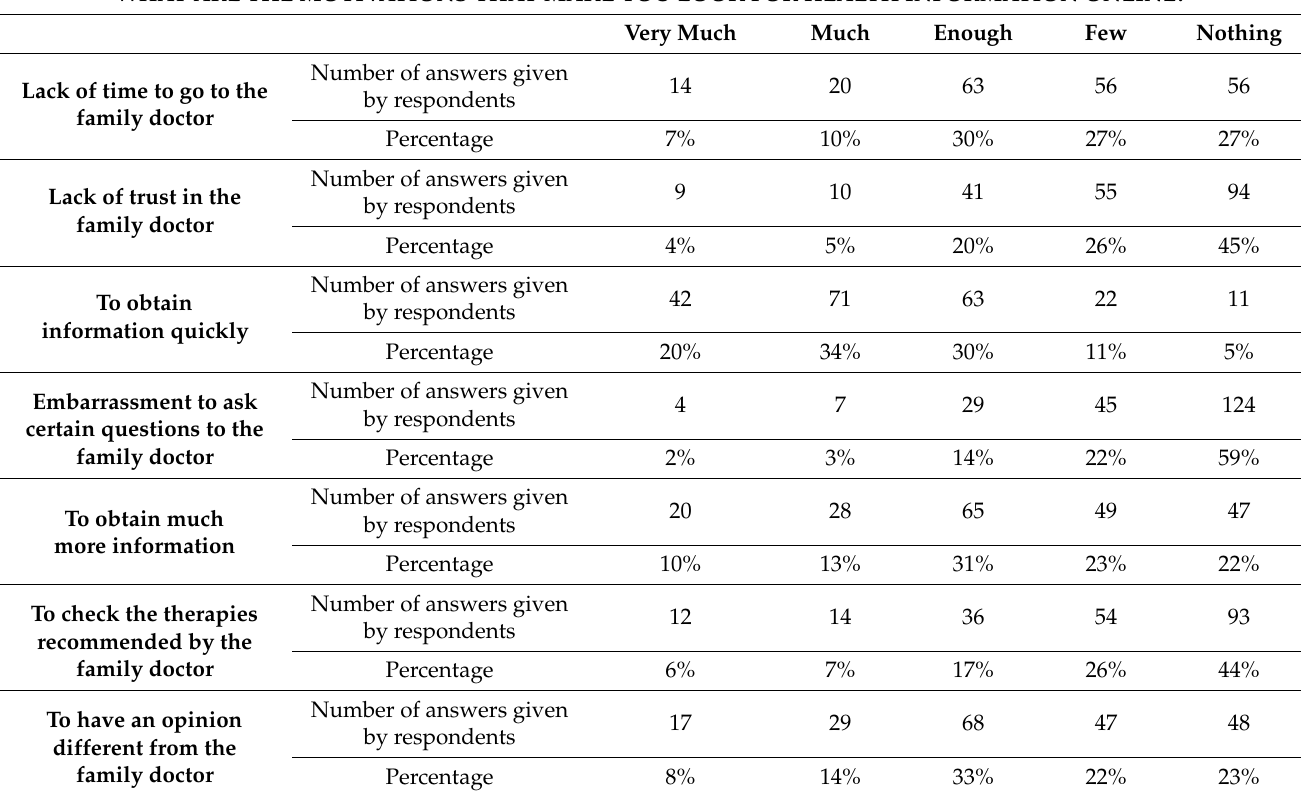
Table 6. Motivation for searching online health